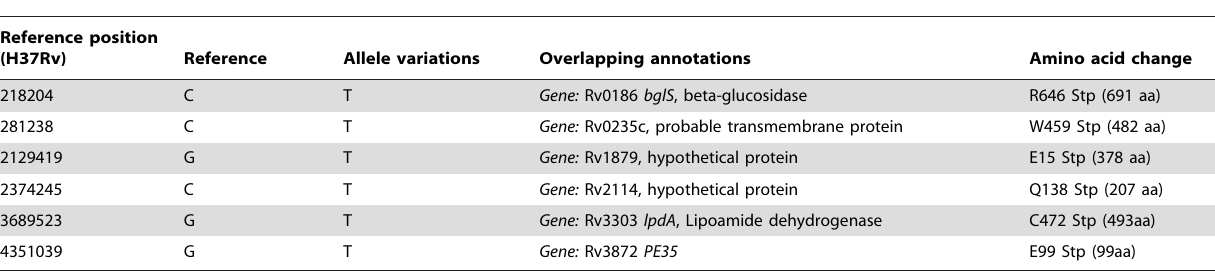
Table 2. SMI-049 specific SNPs resulting in premature stop